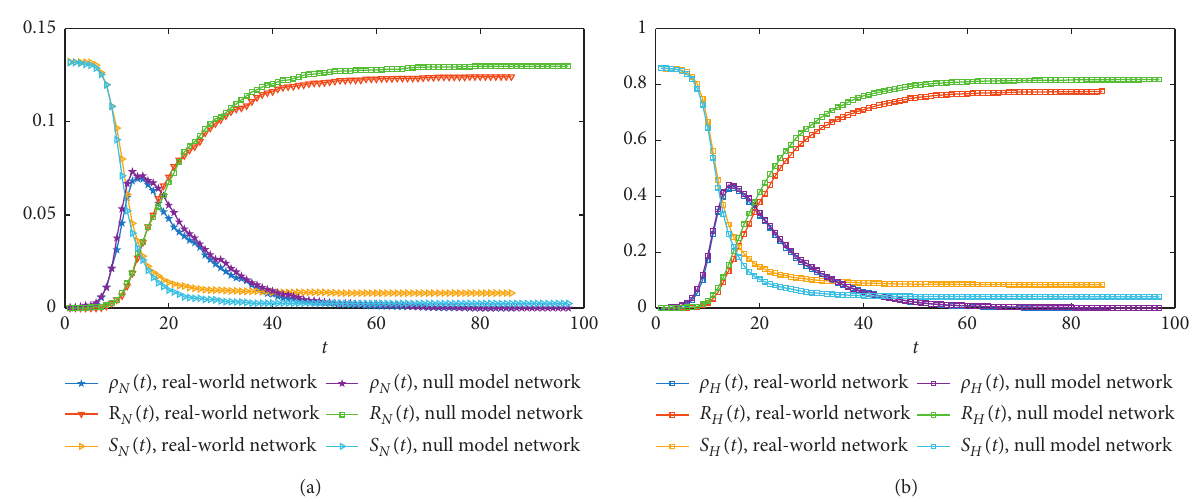
Figure 3: The status of various students evolves over time on social network (a) with and (b) without obvious depressive